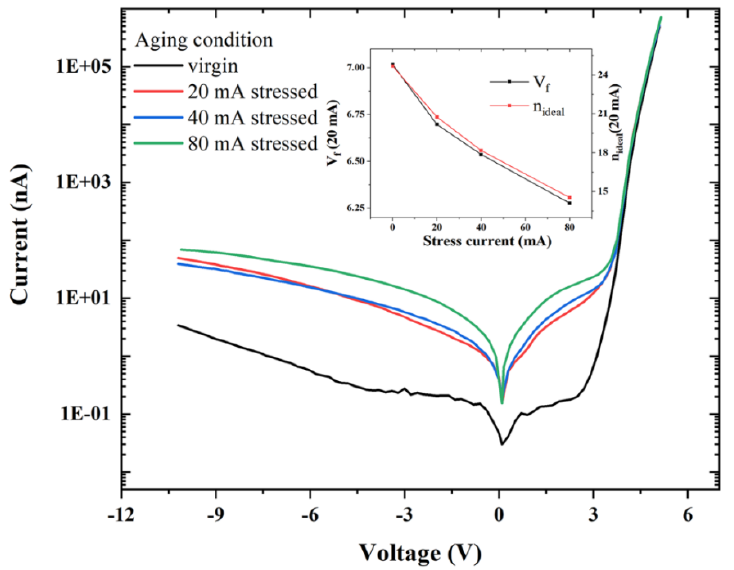
Figure 24. The I–V characteristics of samples stressed at different stress currents. Inset: forward voltage (V f ) and ideality factor variation (n ideal ) under different stress currents. Reproduced with permission [50]. Copyright 2021, AIP.